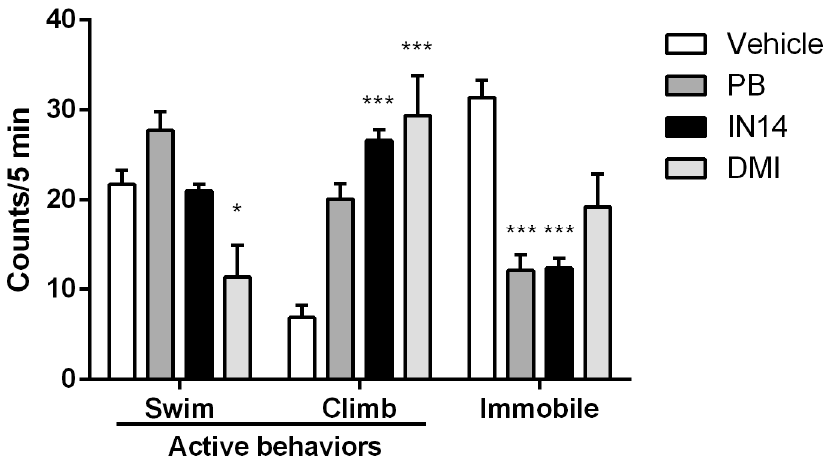
Figure 5. Performance of mice treated with vehicle, IN14, phenylbutyrate (PB) or Desipramine hydrochloride (DMI) during forced swimming test. Bars indicate the incidence of swimming (swim), climbing (climb) and immobility (immobile) during a 5-min test. Data are expressed as mean ± SEM ( n = 8). * p < 0.05; *** p < 0.001 vs. vehicle.